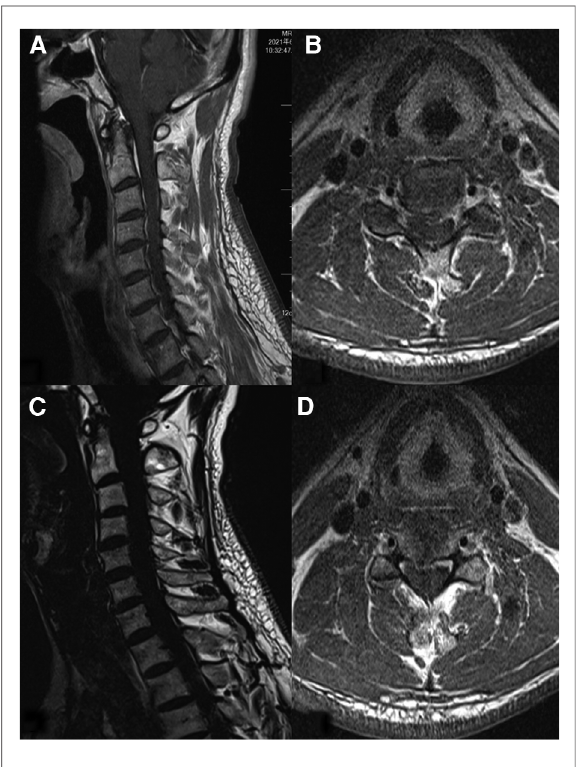
FIGURE 3 ( A ) Preoperative sagittal enhancement MRI of the cervical spine. ( B ) Preoperative C3/4 cross-sectional enhanced MRI. ( C ) Fat suppression of preoperative sagittal enhancement MRI. ( D ) Preoperative C4/5 cross-sectional enhanced